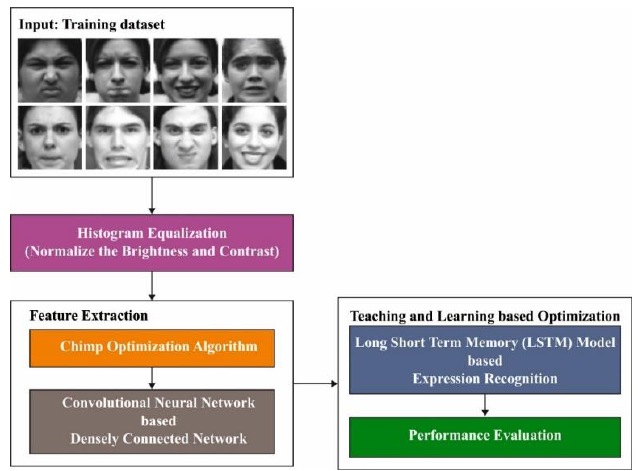
Figure 1. Block diagram of the RFER-EADL